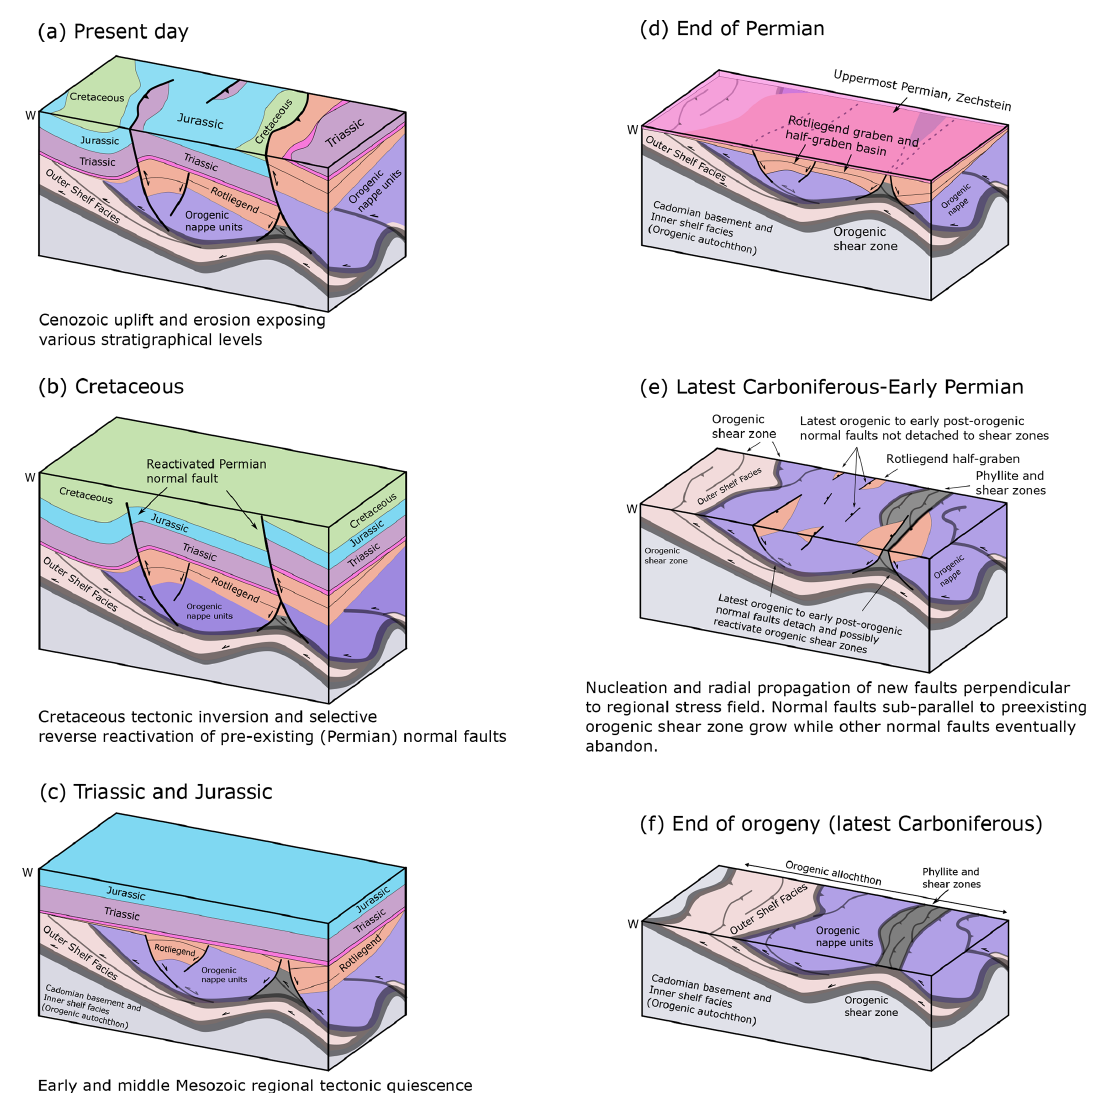
Figure 11. Simplified and generic cartoons showing the relationships between orogenic structures and post-orogenic fault and basin devel- opment (note that the shown general W-directed tectonic transport refers to the initial W–SW-directed nappe stacking). At the latest orogenic and early post-orogenic period, normal faults develop in response to the regional stress field, with some being sub-parallel to the preexist- ing orogenic structures. Some of the normal faults grow laterally, vertically detach into the underlying shear zones, and initiate graben and half-graben basins on their hanging wall side. Normal faults not detaching into preexisting shear zones are abandoned. After a Triassic and Jurassic regional tectonic quiescence, Cretaceous inversion events in Central Europe selectively reactivate Permian normal faults as steep reverse faults, exposing older stratigraphy in the hanging wall side and creating local synclines and anticlines in the vicinity of reactivated